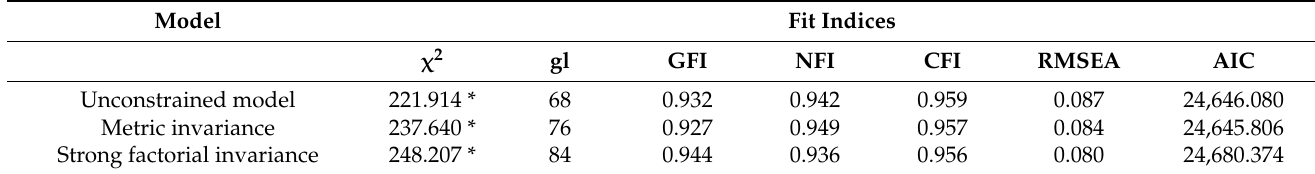
Table 8. Goodness-of-fit indices of each of the models in which factorial invariance was